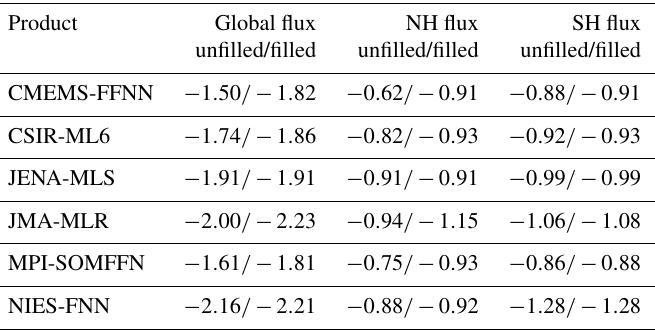
Table 3. Mean air–sea fluxes (PgCyr − 1 ) for 1990–2019 using the mean of three wind products, calculated for the filled global area and the unfilled native “global” area for each p CO 2 product. The Northern Hemisphere (NH) and Southern Hemisphere (SH) fluxes (unfilled/filled) are included to highlight the imbalanced regional effect of the spatial filling